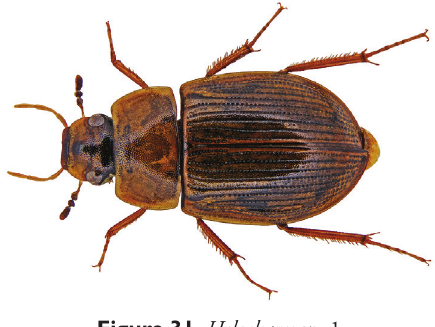
Figure 31. Helochares sp. 1 4.8 mm, iSimangaliso Wetland Park, False Bay (site 27), January 2015 DT Bilton, MS Bird & R Perissinotto leg.